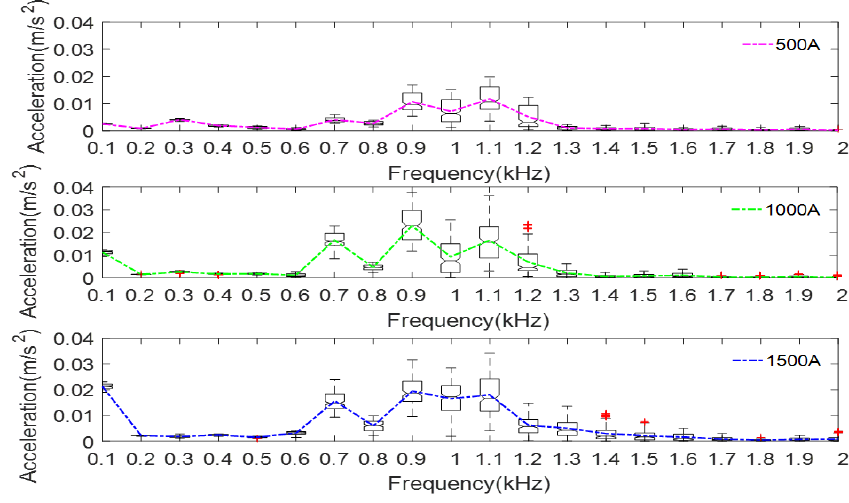
Figure 5. Frequency spectrum distribution of normal case at different current levels.